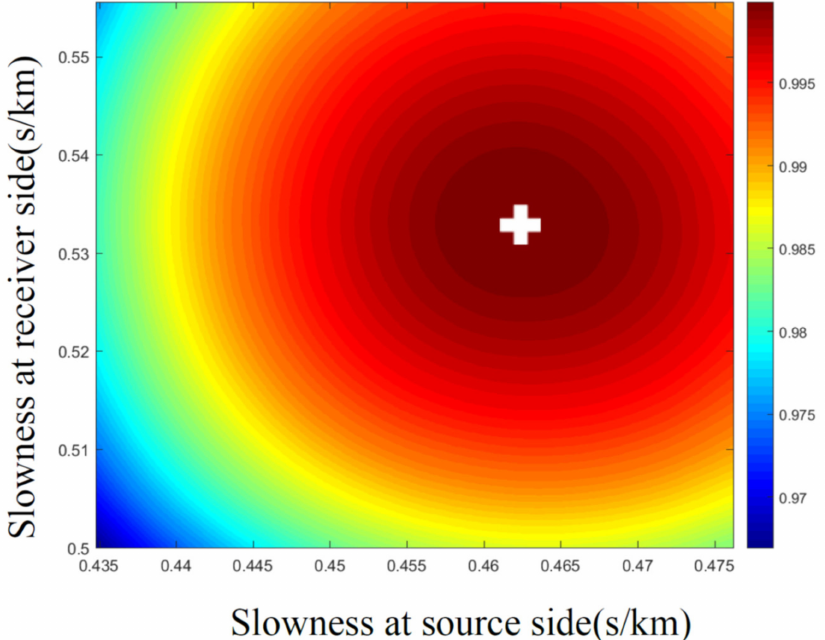
Figure 3. The maximum amplitude of the envelope of the stacked waveforms with respect to source beam slowness and receiver slowness for Stations MS22 and MS34, taken as an example. The color bar represents the amplitude of the stacked waveforms for each slowness, and the white cross indicates the location of the maximum